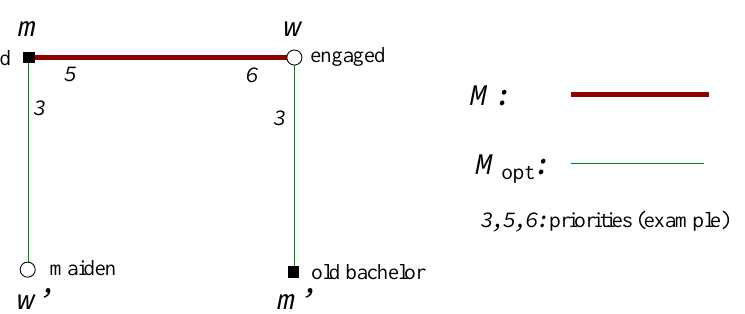
Figure 1. A short augmenting